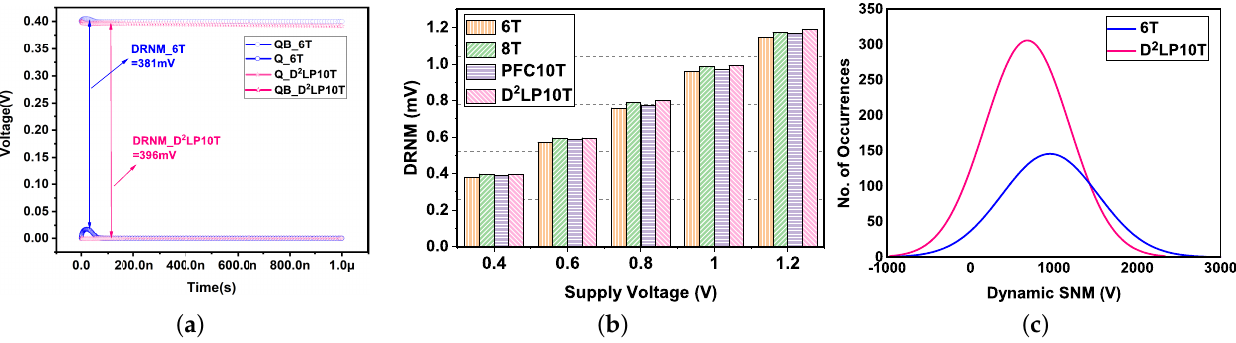
Figure 9. ( a ) Transient response of DRNM for 6T and D 2 LP10T cells at 0.4 V supply voltage. ( b ) DRNM calculation at different supply voltages for considered cells. ( c ) Statistical distribution of 5000 MC simulations for 6T and D 2 LP10T cells at 0.4 V supply